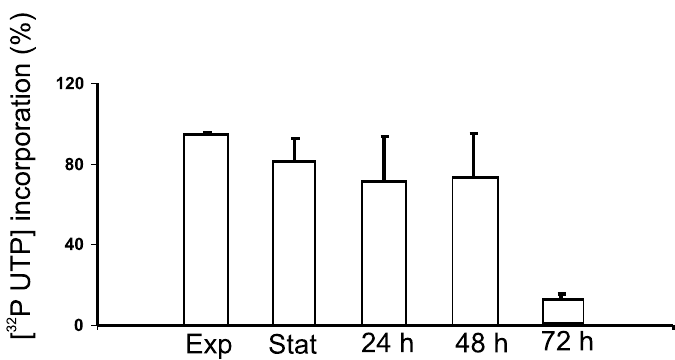
Fig. 3 – Transcription decreases at 72 hours after stress induction. Nuclei were isolated from 2 × 10 8 parasites per time point, washed twice in transcription buffer and labeled in the presence of [ 32 P ] -UTP for 15 minutes at 30 ◦ C. The results are the percentage means of total RNA ± standard deviation relative to exponentially growing epimastigotes of three independent experiments.